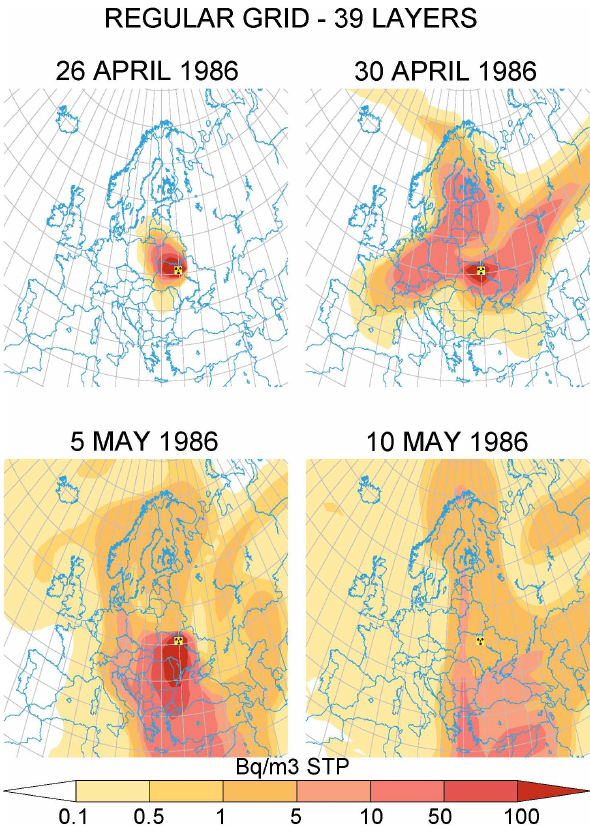
Fig. 4. Daily mean surface 137 Cs activity concentrations (in Bqm − 3 STP) from the Chernobyl accident. Model with regular grid and 39 vertical levels and injection at the real emission height (Ta- ble 1) (RG39L). The figures show the situation during the first day (26 April 1986), at the end of April (30 April 1986), the last day of the emissions (5 May 1986) and on 10 May